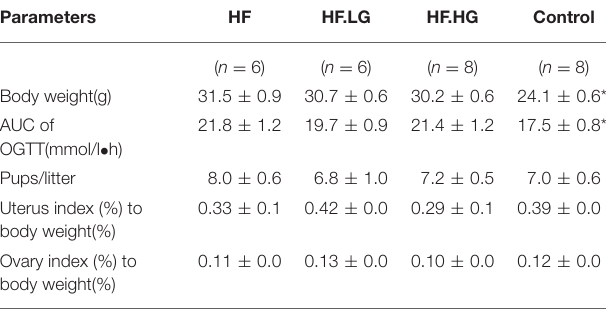
TABLE 1 | Dam and liter